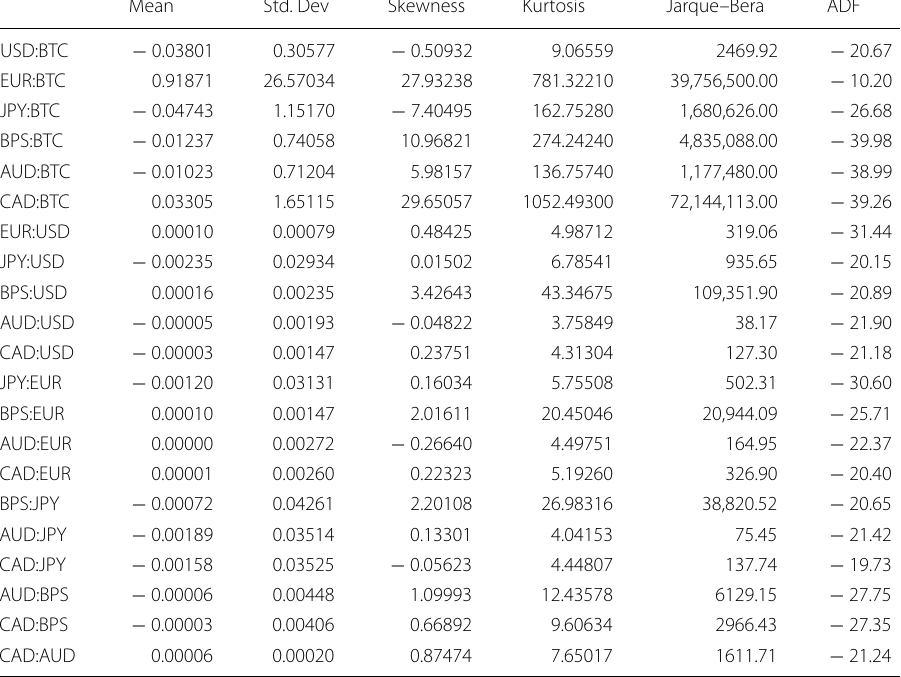
Table 1 Descriptive statistics Bitcoin markets and foreign exchange pairs denominated in six major trading